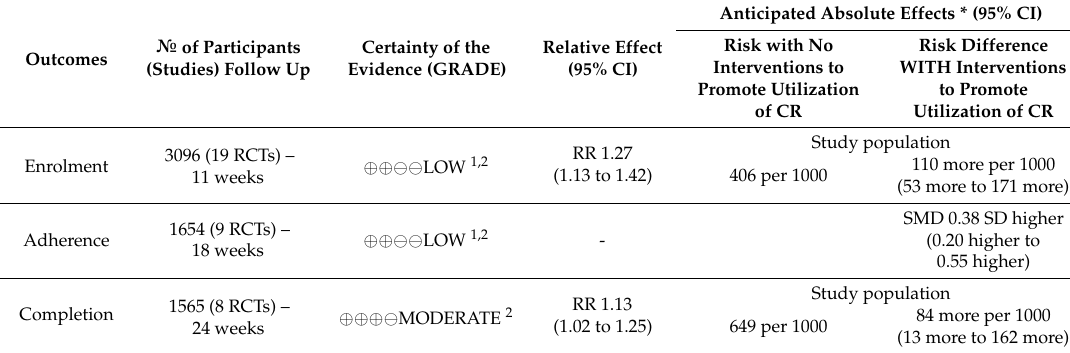
Table 1. Summary of findings.